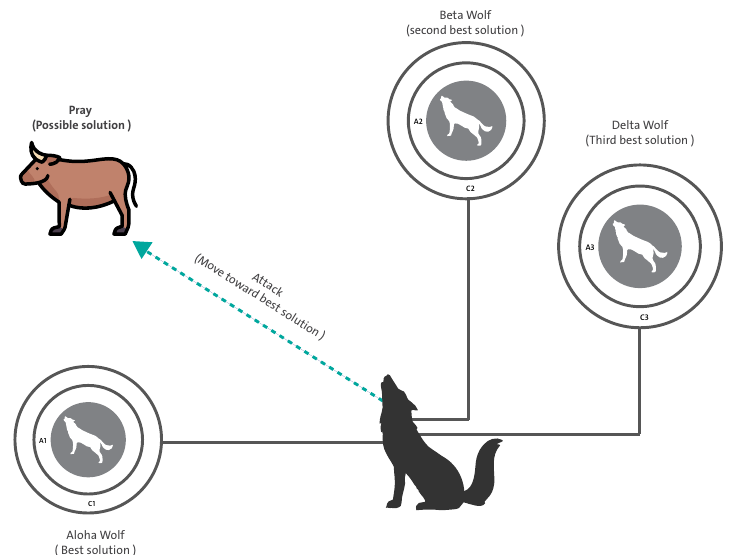
Figure 2. Illustration of the position update strategy for ω wolf based on the position of α and β